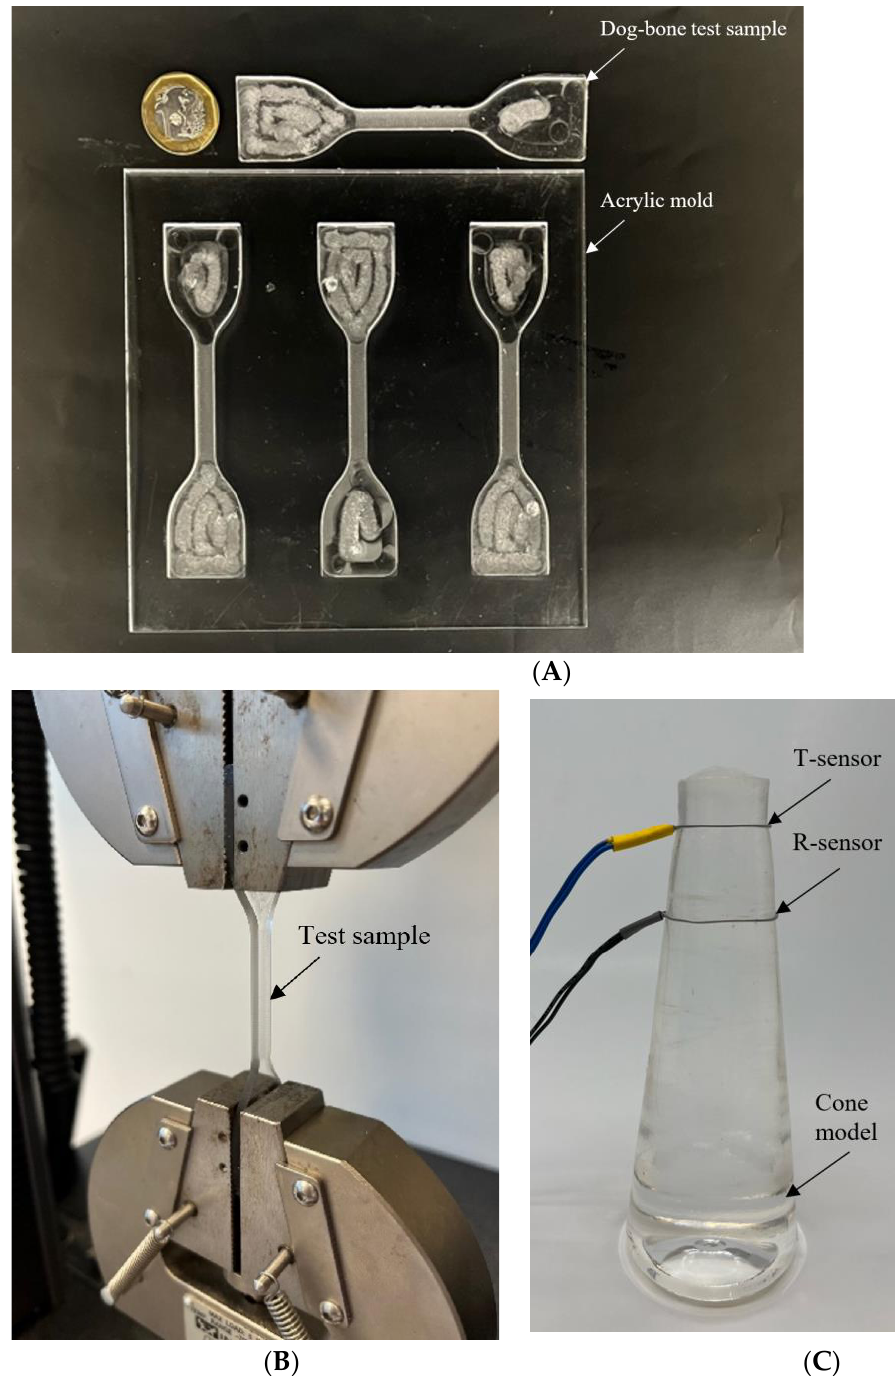
Figure 4. ( A ) Acrylic mold (bottom) and a PDMS dog-bone test sample with dimensions in accord- ance with ASTM standard (top). ( B ) Illustration of test apparatus clamping a dog-bone tensile sam- ple piece. ( C ) Cone shape penile